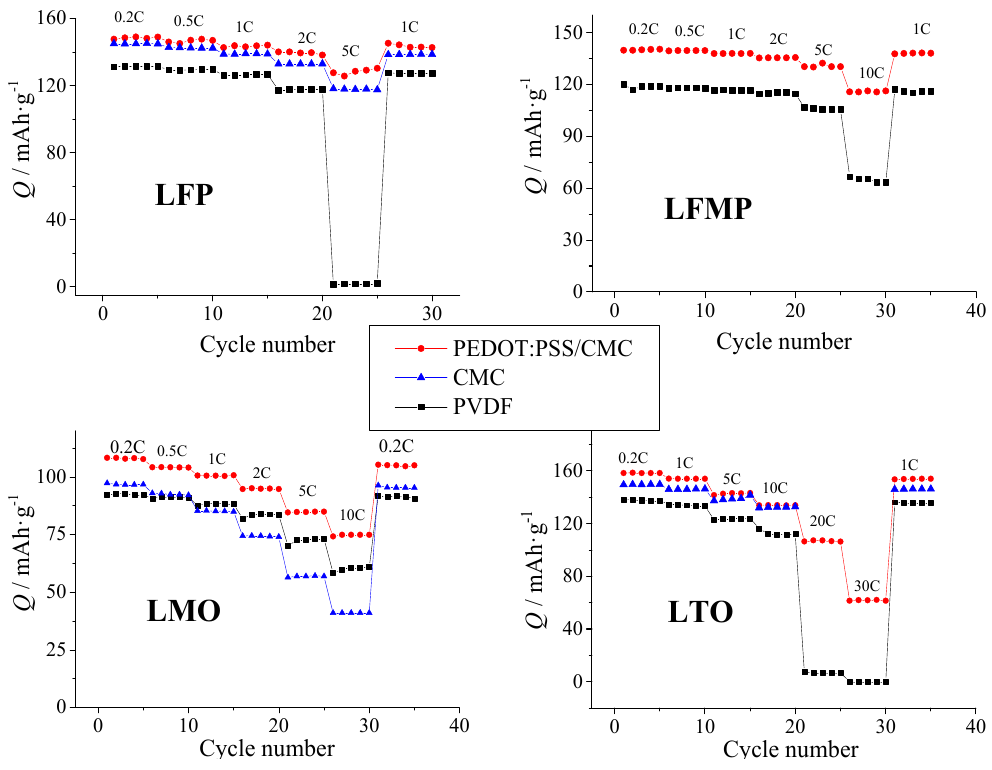
Figure 7. C-rate capabilities of electrodes with PEDOT:PSS/CMC, CMC, and PVDF binders (based on our data in Ref.